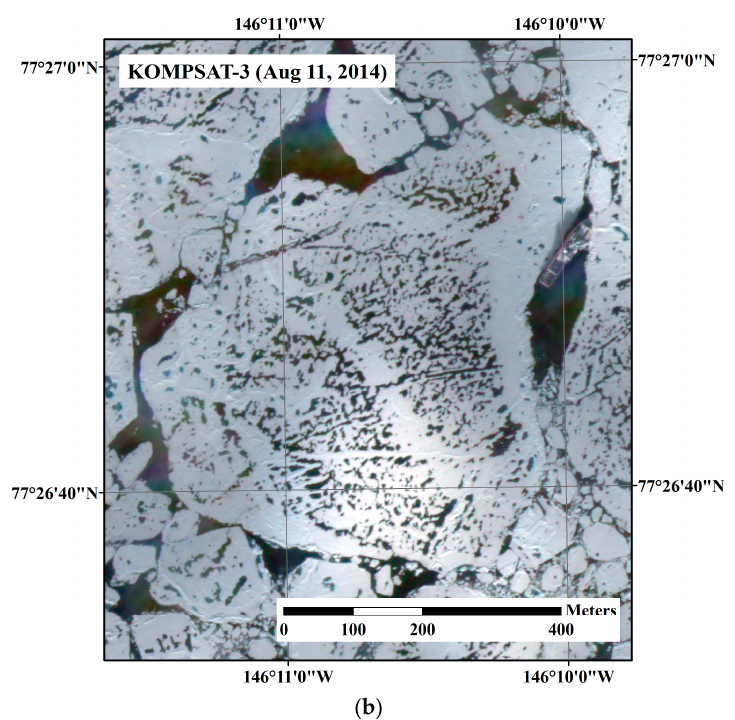
Figure 1. Overview of satellite image acquisition and ITP80 buoy deployment: ( a ) schematic placements of satellite images used to measure sea ice motion and deformation, and synoptic trajectory of the ITP80; and ( b ) a view of the ice floe where the ITP80 was deployed from the Korean icebreaker research vessel (IBRV) Araon, captured by the KOMPSAT-3 satellite on 11 August 2014. Table 1. Specifications of the Korea Multi-Purpose Satelllite-2 (KOMPSAT-2) and Korea Multi-Purpose Satelllite-3 (KOMPSAT-3) satellites and imaging sensors